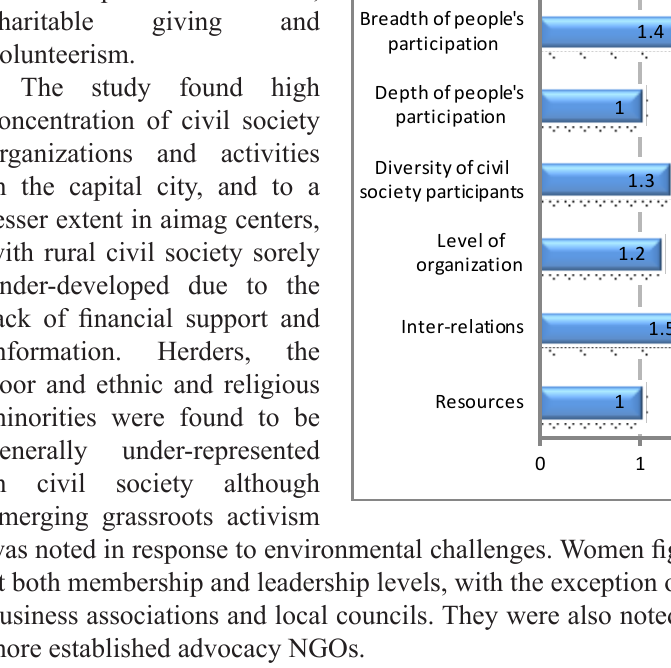
Figure 2. Sub-dimension scores for